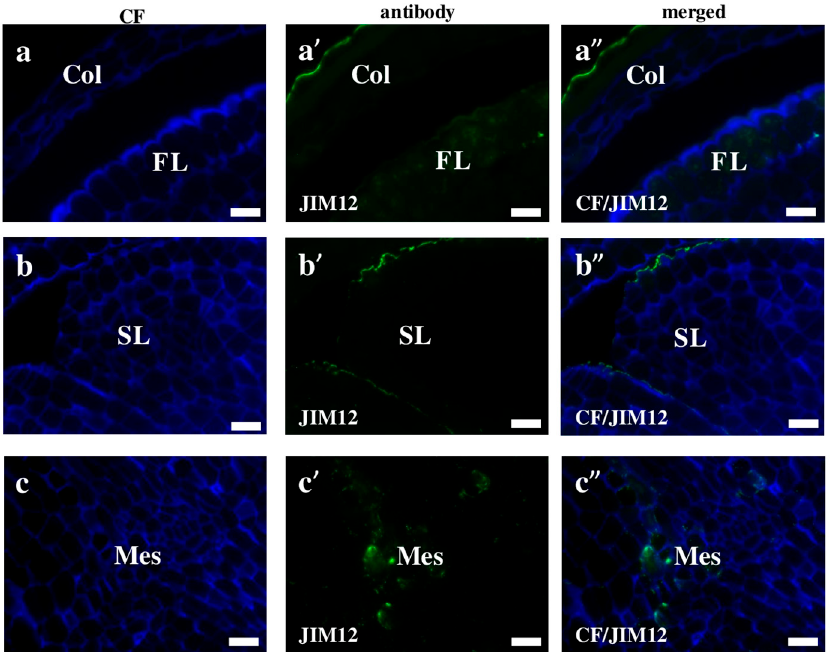
Figure 6. Immunolocalisation of extensins in Brachypodium embryos. ( a – a” ) coleoptile with first leaf; ( b – b” ) second leaf and ( c – c” ) mesocotyl. All with JIM12. Abbreviations: CF—calcofluor, Col—